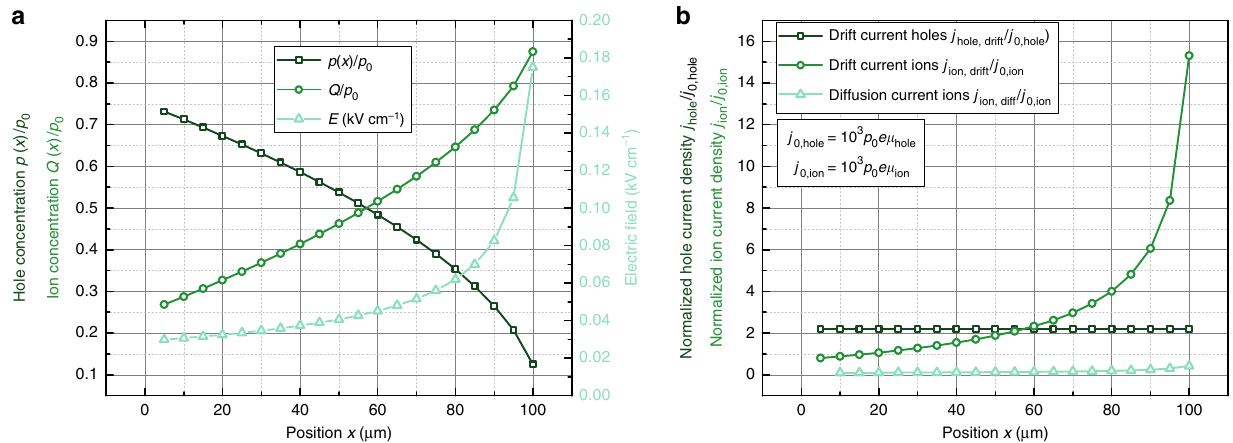
Fig. 4 Lateral ion currents. a Normalized hole density, ion density, and electric fi eld inside a hypothetical p-type OECT ( W = 1 mm, d = 200 nm, = 10 20 cm − 3 , μ = 0.25 cm 2 (Vs) − 1 , V = 0.2 V, V = − 0.5 V). b Although the normalized hole current is constant across the channel, the L = 100 μ m, p 0 hole GS DS ionic drift and diffusion current increases, which indicates that the current model leads to a non-steady-state solution.